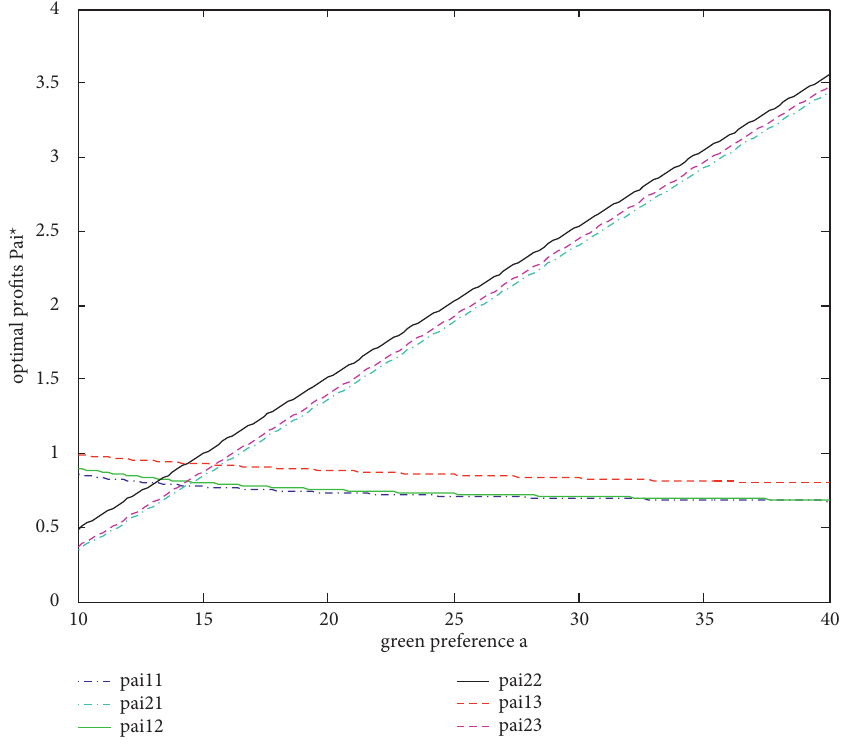
Figure 5: Optimal profits with green